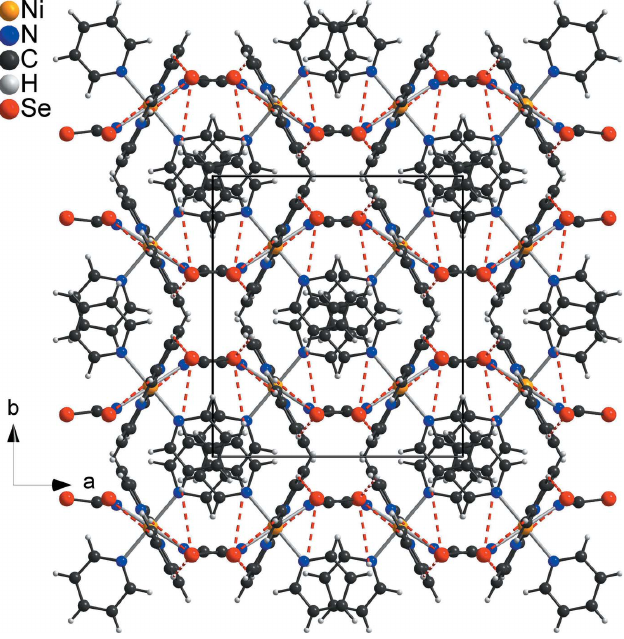
Figure 3 Crystal structure of the title compound with labeling and displacement ellipsoids drawn at the 50% probability level. Symmetry code: (i) (cid:3) x + 3 (cid:3) y + 3 , (cid:3) z + 1. 2